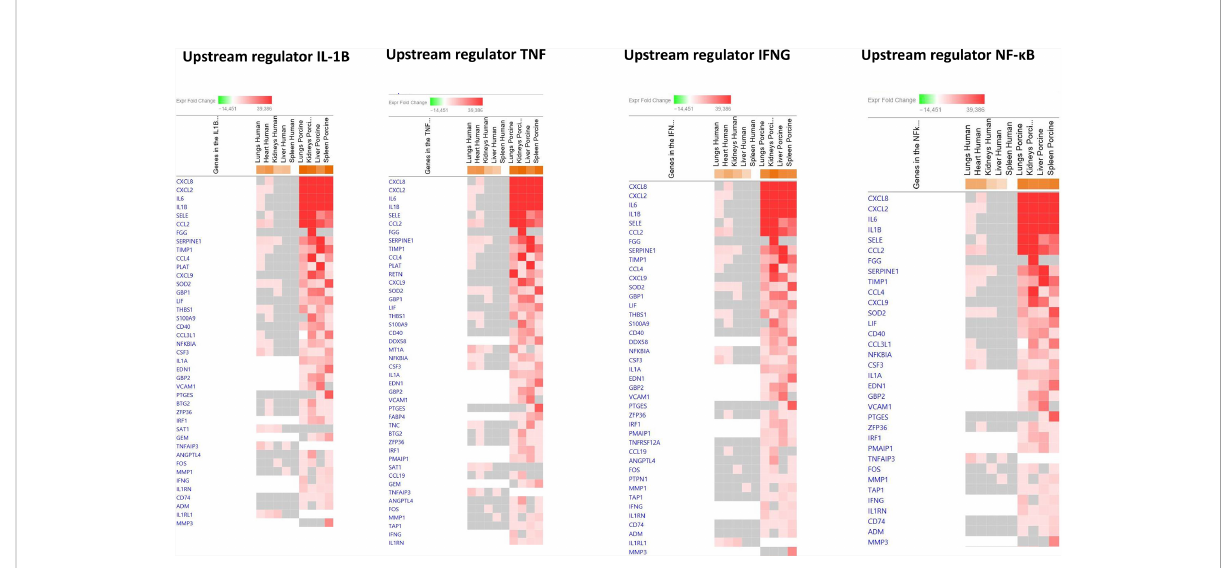
FIGURE 4 Predicted gene signaling pathways from the top upregulated upstream regulators in FFPE tissue samples from patients with meningococcal septic shock and in organs from porcinis infused with exponentially increasing numbers of N. meningitidis (reference strain H44/76) vs. controls. The Z-score indicates predicted activation state of genes in the upstream regulator signaling network. Orange or lighter shades of orange indicate a positive Z-score and upregulation of the upstream regulator. The transcripts in the signaling network are expressed as Fold Change (FC) values. Red or lighter shades of red indicates positive FC-values and upregulation of transcripts; green color or lighter shades of green indicate negative FC-values and downregulation of transcripts. The color gray indicates that a predicted activation state of a gene/transcript in the upstream regulator pathway signaling network is not affected (the gene/transcript was in the dataset but did not pass the analysis cutoffs). White color indicates that gene/transcript are not present in the dataset.